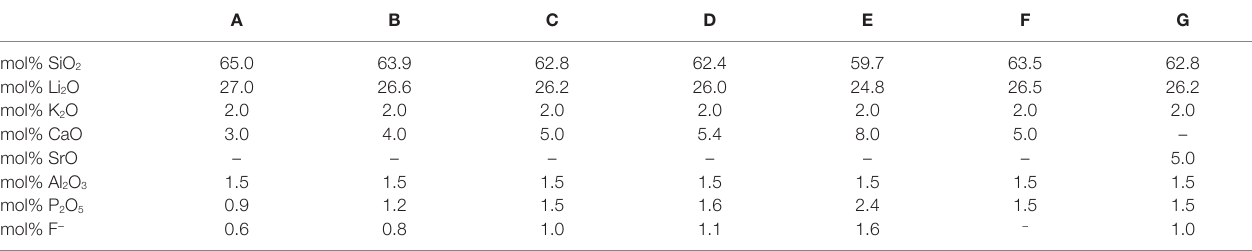
TaBle 1 | chemical compositions of the base glasses calculated from the initial weight of the raw materials, taking into account the evaporation of P 2 O 5 and F −